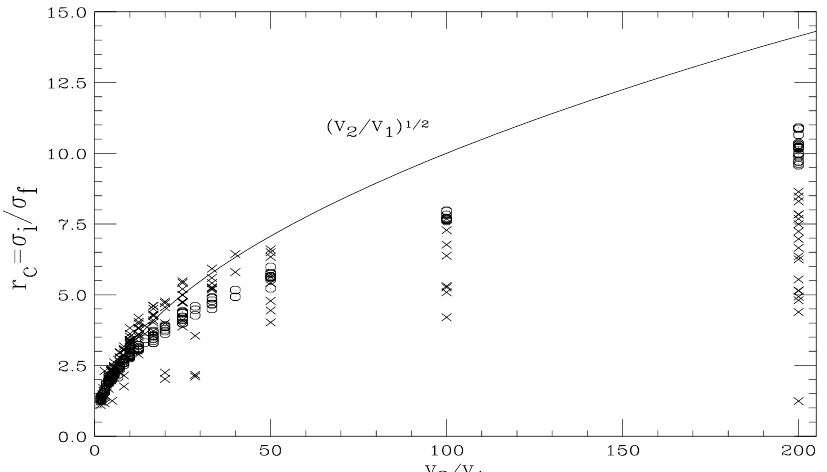
FIG. 6. Compression ratio versus voltage ratio. Experimental results are denoted by crosses. Simulation result is denoted by circles with initial condition according to the initial bunch length. Linear theory is denoted by the solid line. The value of V 2 is fixed at 1000 V while V 1 is varied to obtain different compression ratio. The compression ratio spread at each voltage ratio is caused by different initial beam conditions and experimental bandwidth